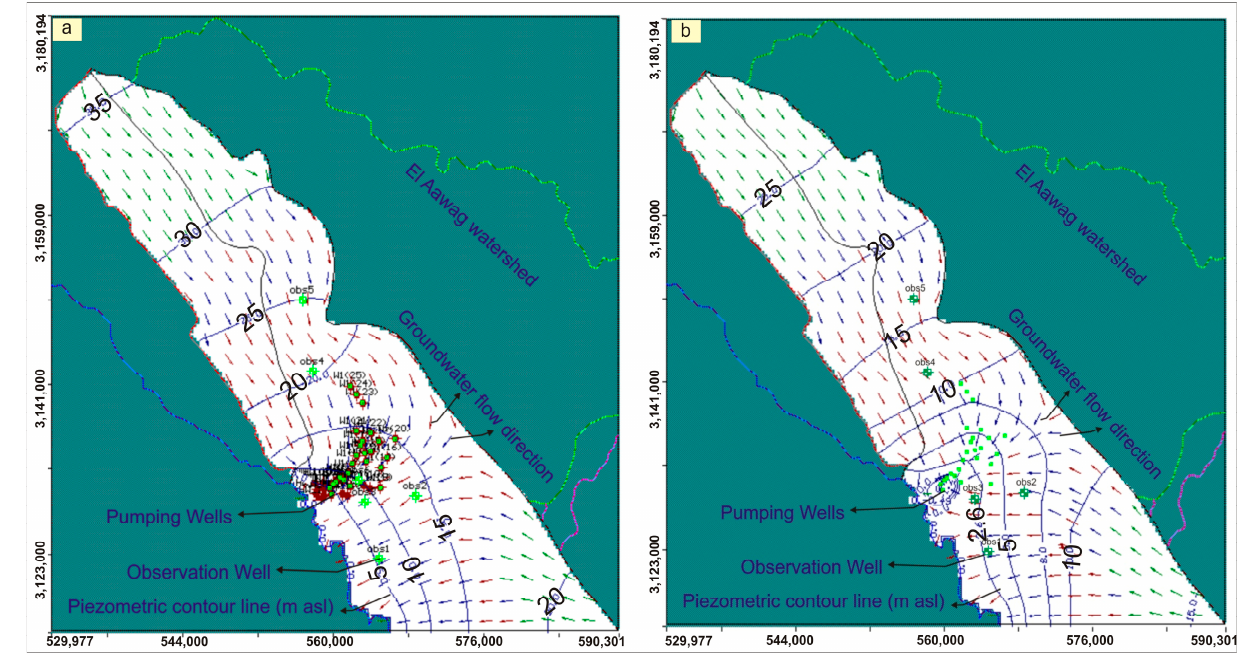
Figure 12. Flow directions and piezometric heads: ( a ) model scenario No. 1; ( b ) model scenario No. 2. Scenario